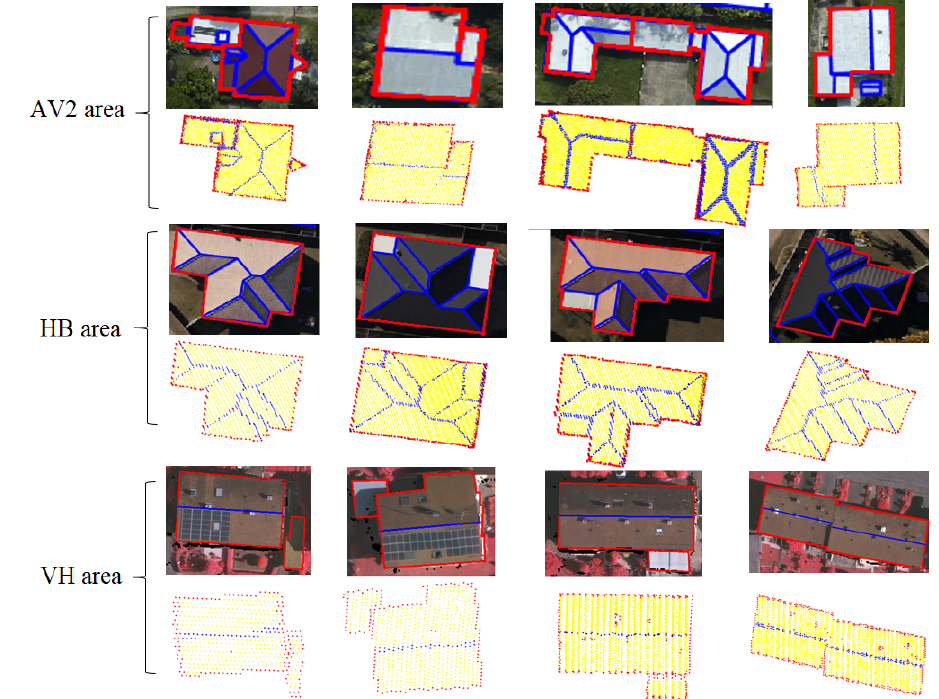
Figure 14. Combined fold (blue), boundary (red), and planar (yellow) points compared with the reference 3D building roof [7] for several buildings from the test datasets. While the first, third, and fifth rows show the reference information overlaid onto of the building roofs, the second, fourth, and sixth rows show the extracted results by the proposed